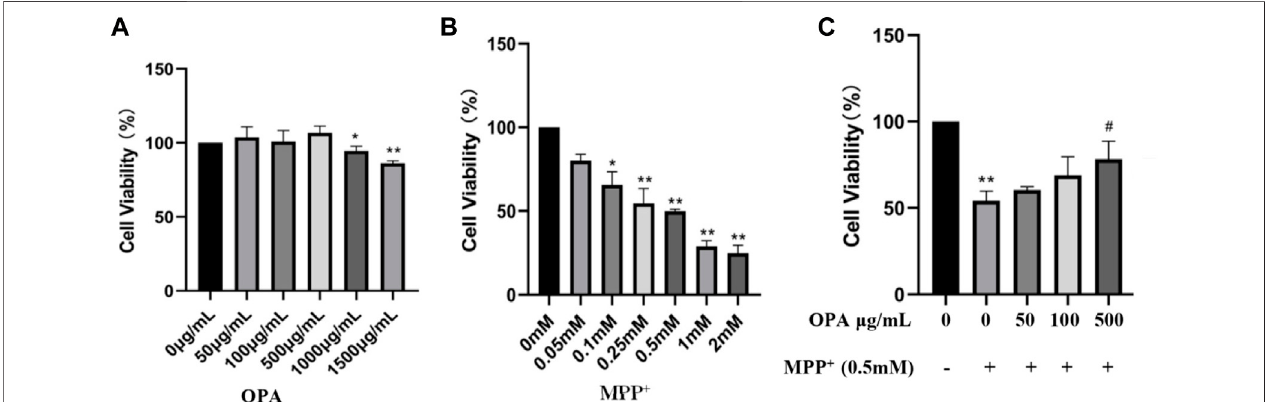
FIGURE 1 | Effects of OPA on MPP + -induced death of SH-SY5Y cells. SH-SY5Y cells were incubated for 24 h with different concentrations of (A) OPA and (B) MPP + alone. (C) SH-SY5Ycells werepretreated withdifferent concentrationsofOPAfor24 hand then exposed toMPP + (0.5 mM) foranadditional 24 h. The viabilityof SH-SY5Y cells that untreated with OPA and MPP + was considered as control group. Data were presented as mean ± SD for three independentexperiments. * p < 0.05, ** p < 0.01 compared with control cells untreated with OPA and MPP + ; # p < 0.05 compared with MPP + -treated